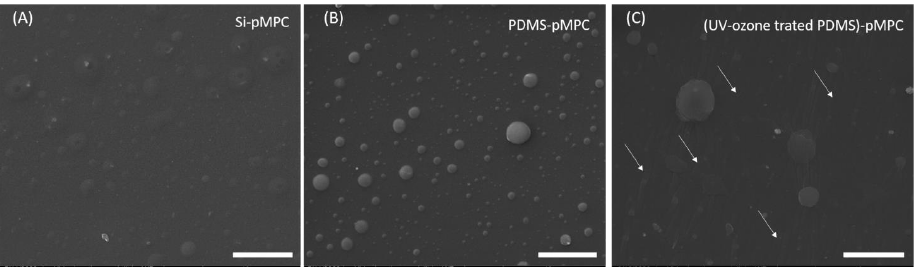
Figure 4. SEM images of pMPC coatings obtained by MAPLE at 450 mJ/cm2 onto Si ( A ), PDMS ( B ) and UV – Ozone treated PDMS (2 h) ( C ). The white arrows indicate the wave-like structures observed for the coatings deposited on UV – Ozone treated PDMS. Scale bar: 10 µm.